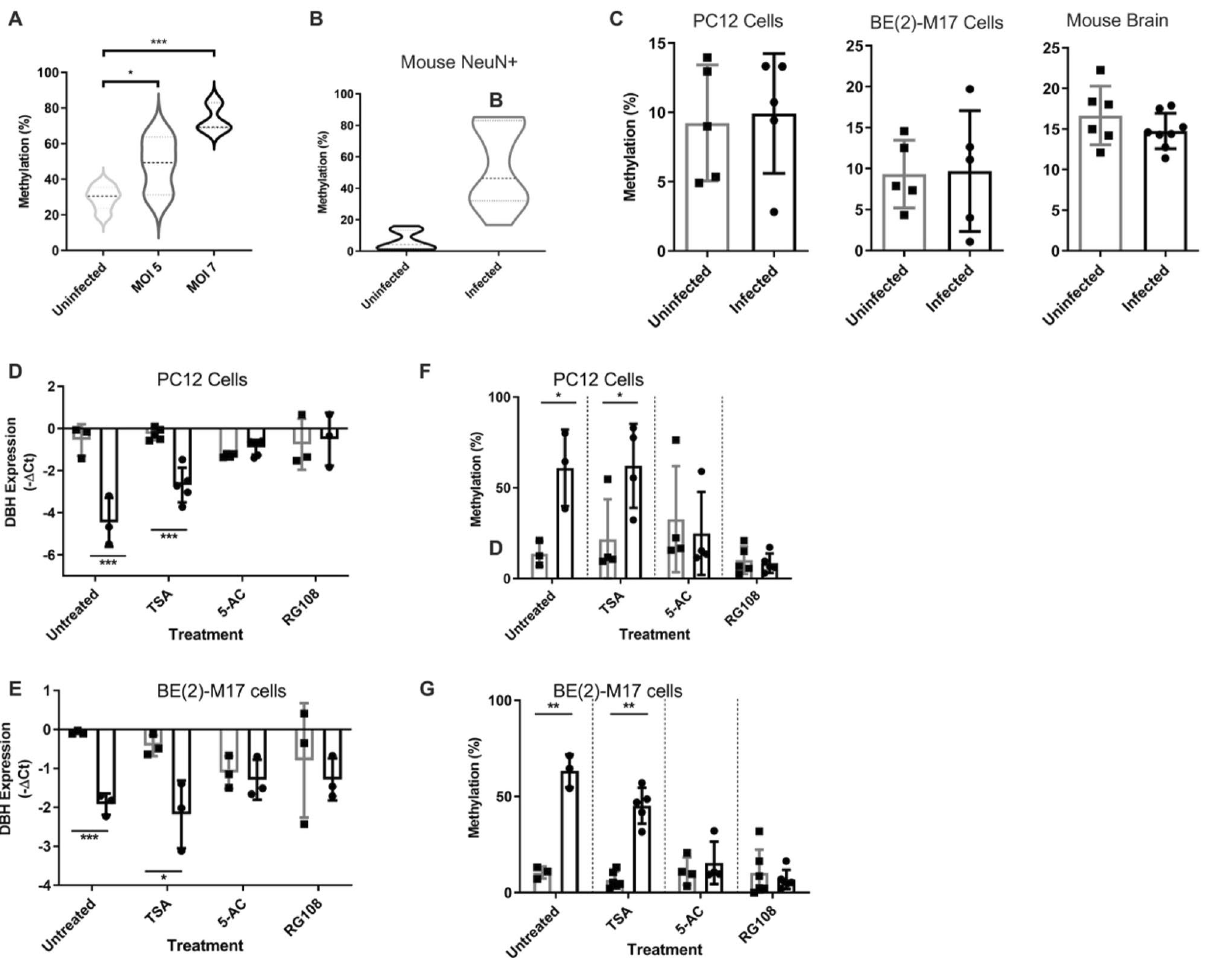
Figure 4. Transcriptional and DNA methylation changes with infection. (A) DBH promoter methylation was measured by MSRE-qPCR in organotypic coronal midbrain section cultures. Slice cultures were either uninfected (light grey, n = 6) or infected with wild-type induced-bradyzoite T. gondii at MOI 5 (dark grey, n = 3) and MOI 7 (black, n = 3). Infection was monitored for 5 days by light microscopy; biological repeats contain 3 slices from the same rat * p = 0.04, *** p = 0.000051 shown. One-way ANOVA, p = 0.0005 Tukey’s post hoc test MOI 7 vs uninfected p = 0.0004. (B) Methylation at the DBH promoter region in neurons from uninfected (grey, n = 9) and chronically-infected (black, n = 11) mice. Neurons were enriched from harvested brains by FACS using NeuN antibody and DBH methylation quantified by MSRE-qPCR. p = 0.0004. (C) Total genomic DNA methylation measured by ELISA of both uninfected and infected rat catecholaminergic PC12 cells (n = 3, p = 0.52), human neuronal BE(2)-M17 cell (n = 5, p = 0.59) and neuronal nuclei enriched by FACS from mouse brain tissue for uninfected (n = 6) and chronically-infected mice (n = 3, p = 0.15). No significant change in methylation was identified by Student’s t tests, ± SEM shown. (D) Expression of DBH mRNA measured RT-qPCR relative to GAPDH following treatments. Uninfected (grey) and T. gondii -infected (black) noradrenergic PC12 cells treated with trichostatin A (TSA), 5-azacytidine (5-AC) and RG108; n = 5, ** p < 0.01. (E) As in ( D ) with noradrenergic human BE(2)-M17 cells treated with TSA, 5-AC and RG108; n = 5, * p < 0.05. n = 5. Student’s t test, ± SEM shown. (F) 5 ′ DBH hypermethylation was measured by MSRE-qPCR (as above). Uninfected (grey) and T. gondii -infected (black) PC12 cells were treated with trichostatin A (TSA), 5-azacytidine (5-AC) and RG108; n = 5, ** p < 0.01. (G) Uninfected (grey) and infected (black) BE(2)-M17 cells treated as in ( F ) with TSA, 5-AC and RG108; n = 5, * p < 0.05. Student’s t test, ± SEM